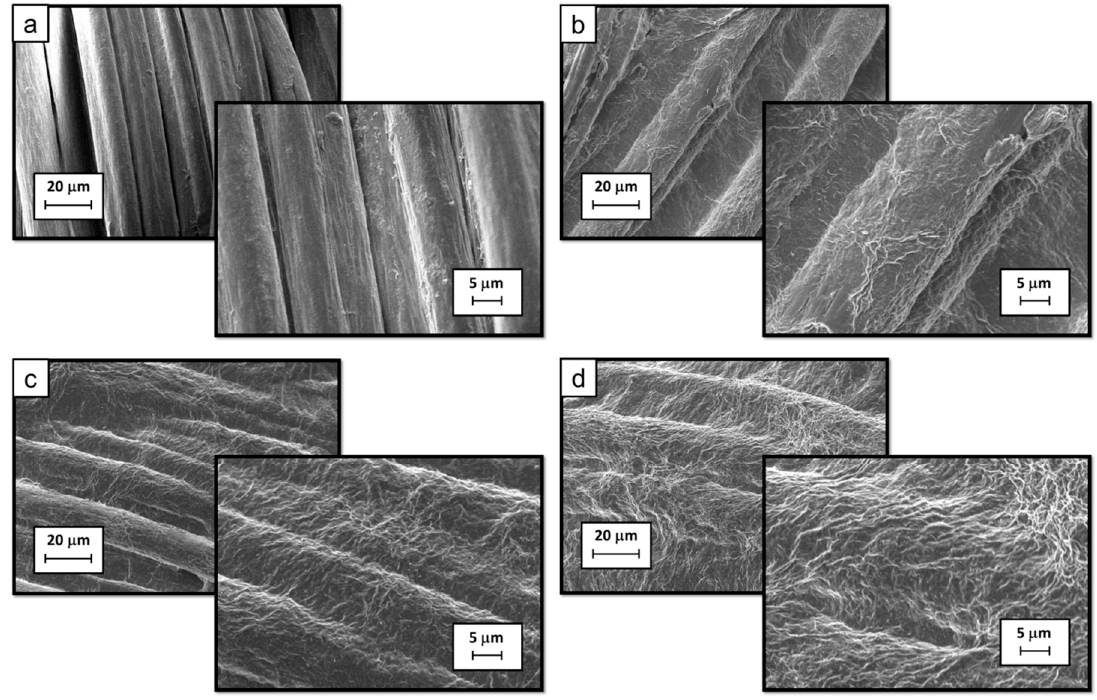
Figure 3. SEM micrographs of unmodified ( a ) and treated acrylic fabrics with 5% ( b ); 10% ( c ) and 20% ( d ) add-ons.